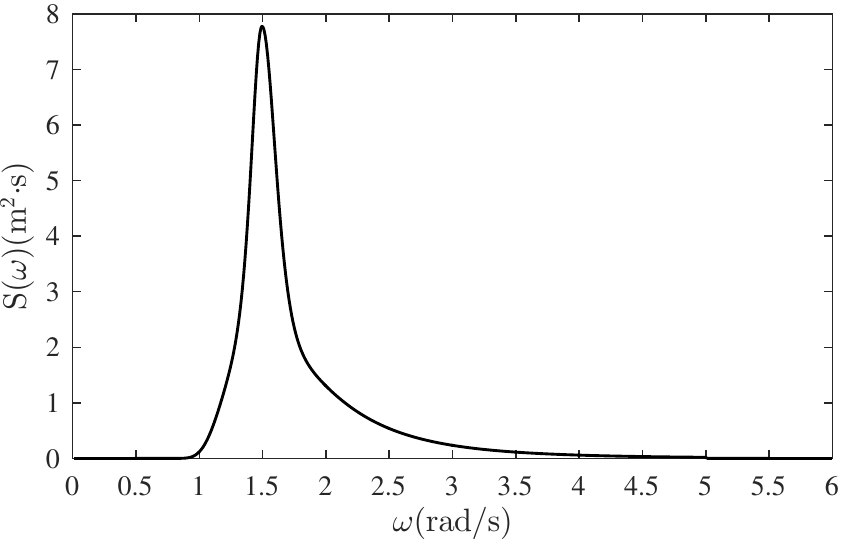
Figure 8. The used JONSWAP spectrum. Taking into account the experimental cost, only one irregular wave was selected. The time history of the measured stable wave elevation is plotted in Figure